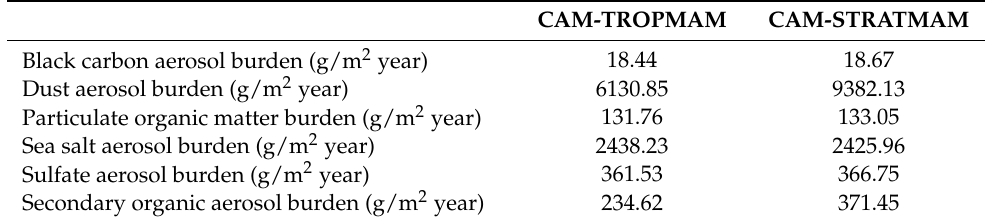
Table 2. Global burden of aerosols in the two configurations of the model: tropospheric chemistry only (CAM-TROPMAM) and tropospheric and stratospheric chemistry